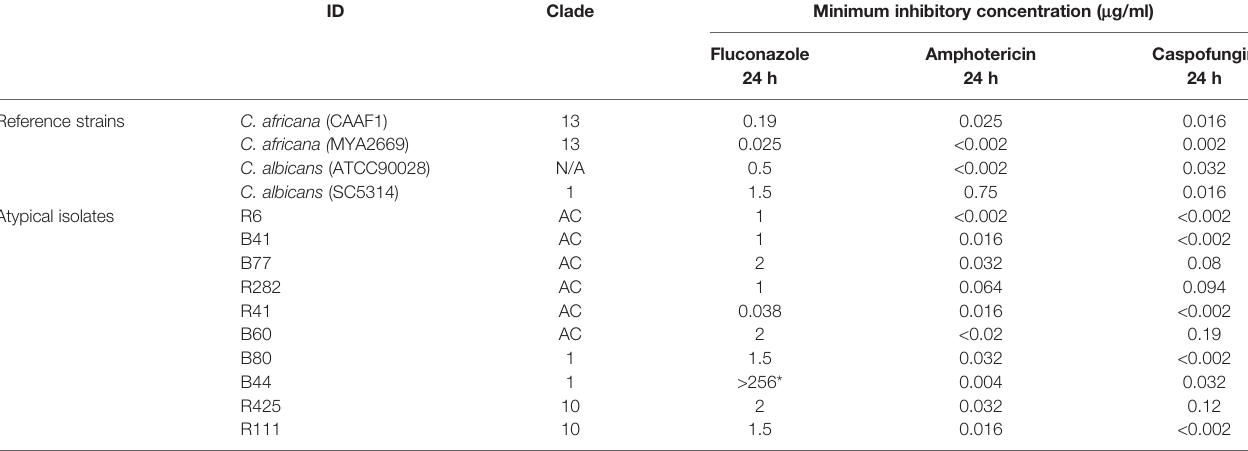
FIGURE 4 | Pathogenicity in a G . mellonella infection model. (A) A Kaplan – Meier plot of G. mellonella survival after injection with 10 5 CFU/larvae at 37°C. The data is expressed as survival percentage. No larval killing was observed in control larvae injected with an equivalent volume of PBS (data not shown). (B) log-rank (Mantel-Cox) statistical comparison of each survival curve. Data is representative of three independent experiments. Atypical clade shown in black, clade 1 red and clade 10 green. TABLE 3 | Atypical C. albicans antifungal activity. ID Clade Minimum inhibitory concentration ( m